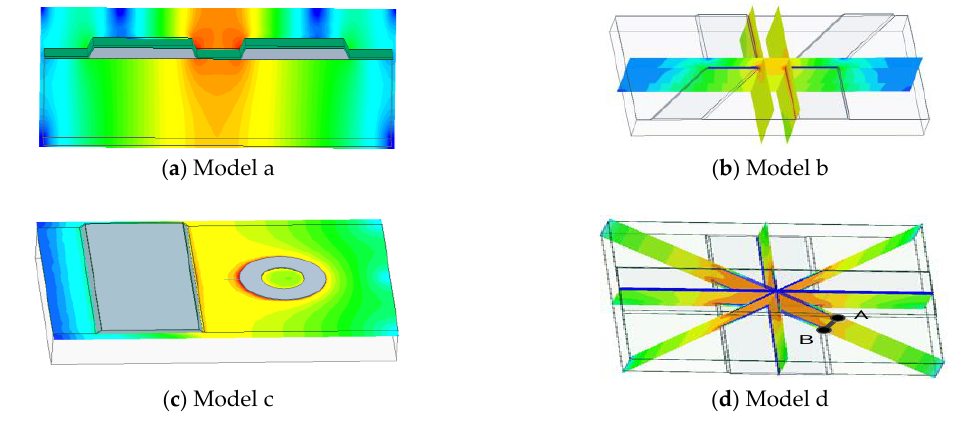
Figure 3. Electric field simulation distribution of the four models.